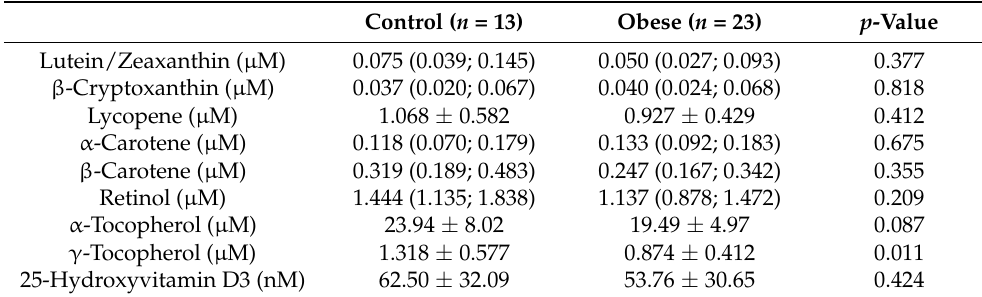
Table 2. Plasma lipid-soluble micronutrient concentrations by study group.